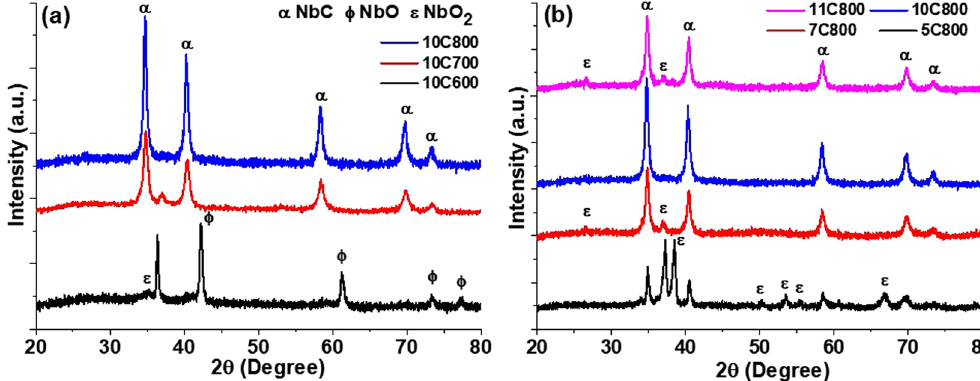
Figure 1. X-ray patterns of all the synthesized samples ( a ) at different temperatures with holding time of 10 h and ( b ) at 800 °C with different holding time of 5, 7, 10 and 11 h.